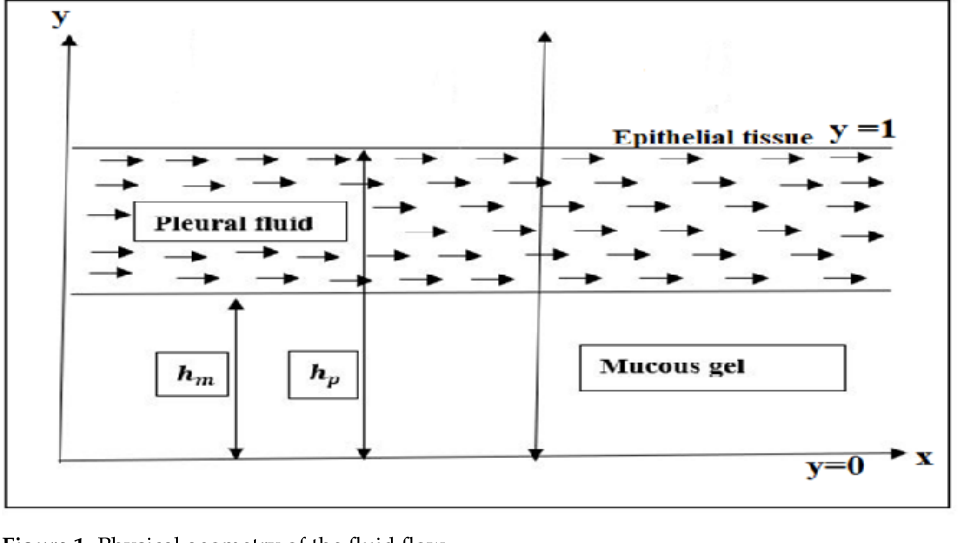
Figure 1. Physical geometry of the fluid